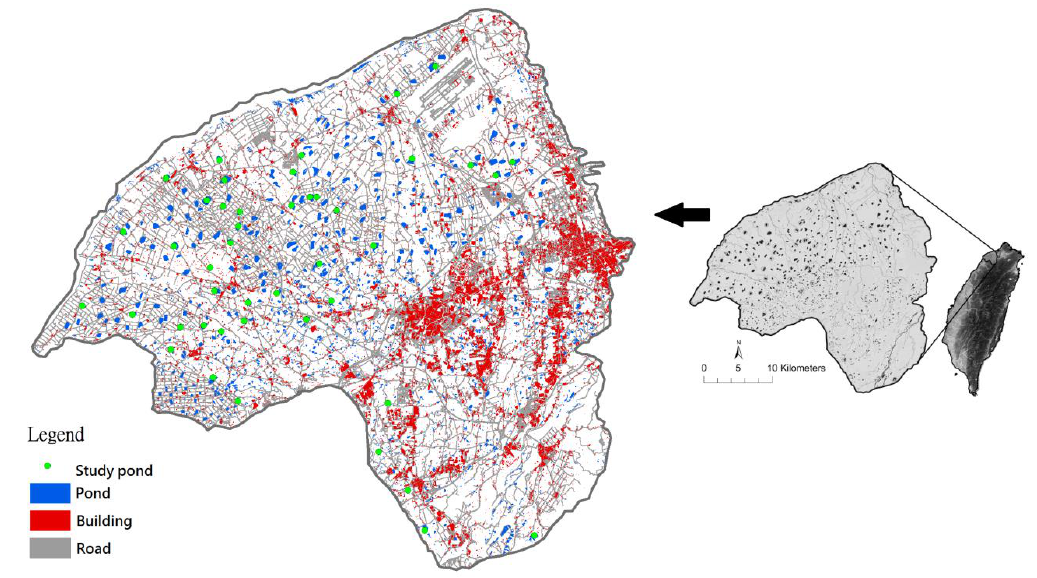
Figure 1. Study area in Taoyuan Tableland, Taiwan.